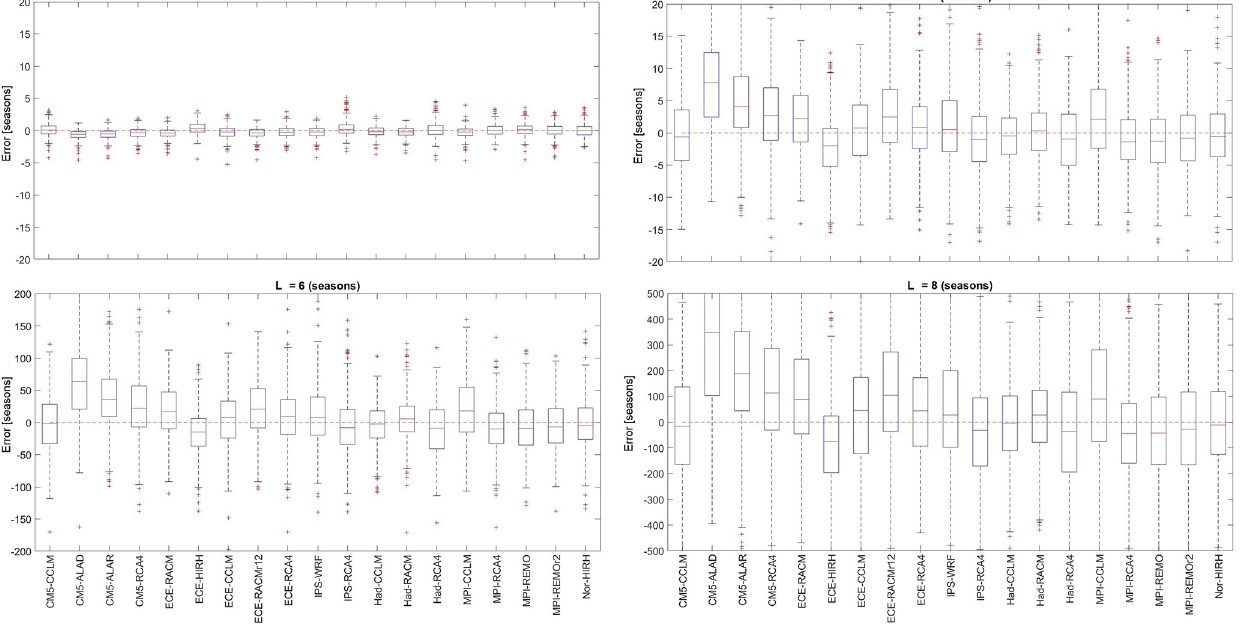
Figure 13. Box plots representing the frequency distribution of RCM percentage errors in the return period of drought events of duration L equal to 2, 4, 6, and 8